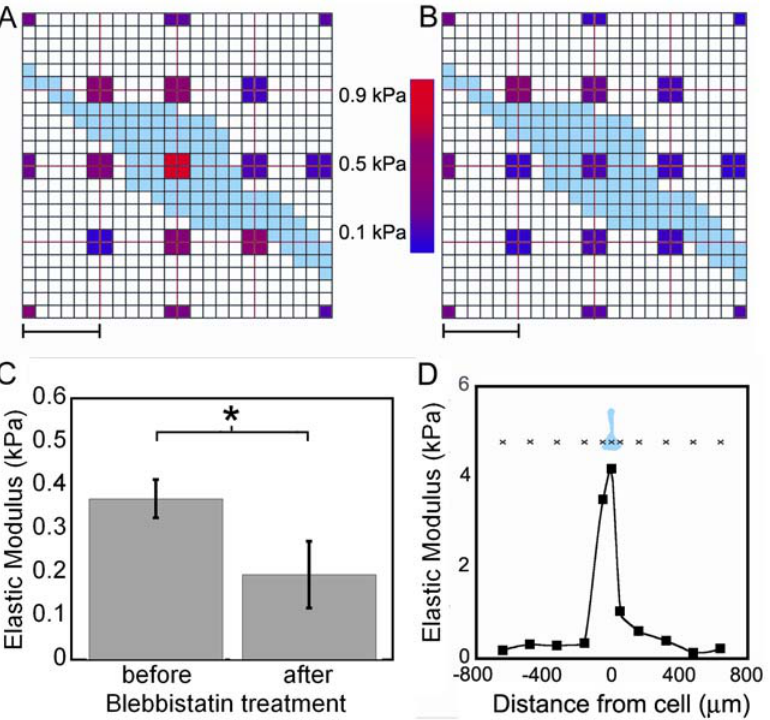
Figure 6. The cell applied strains are creating local stiffness gradients. AFM generated stiffness maps of a fibroblast (in blue) on a 2 mg/ml fibrin gel before (A) and after (B) blebbistatin treatment. Scale bar=30 m m. The center measurement is of the cell stiffness not the gel stiffness. C) Average tensile modulus of a 2 mg/ml fibrin gel 10–15 m m from the cell’s edge before and after blebbistatin treatment. Reported as mean 6 SD, 3 measurements per cell, 3 cells in total, *: p , 0.01 using a paired students t-test D) A stiffness line scan of a hMSC (in blue) on a fibrin gel. Reported stiffness is an estimated tensile modulus. Similar results were seen in independent experiments. fibrinogen concentration (Fig. 7A and 7B). For cells cultured on 1 and 2 mg/ml fibrin gels, cell orientation angle, defined as the angle between the long axis of the cell and the shortest line to the nearest cell, decreased as the distance between the two cells decreased (Fig. 7C). The range over which this effect occurs corresponds to the range over which hMSCs displaced beads in